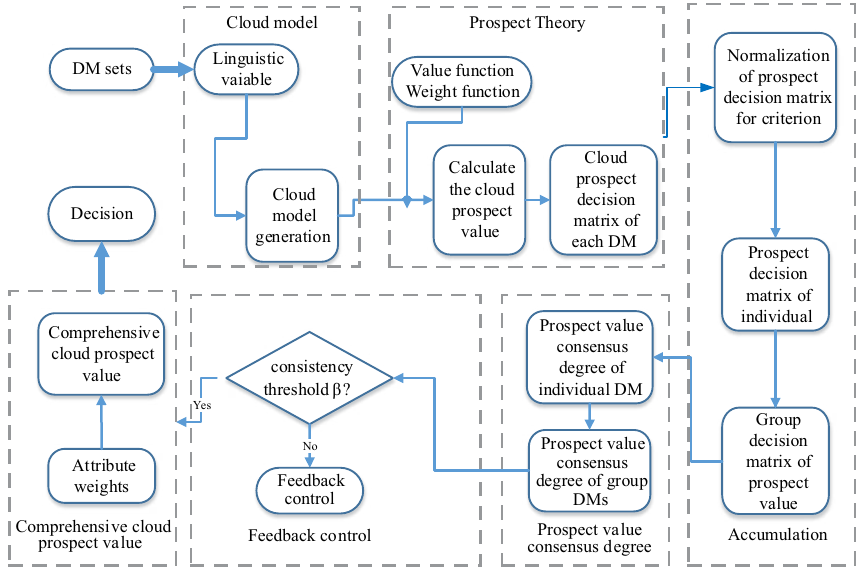
Fig. 1. Group decision model